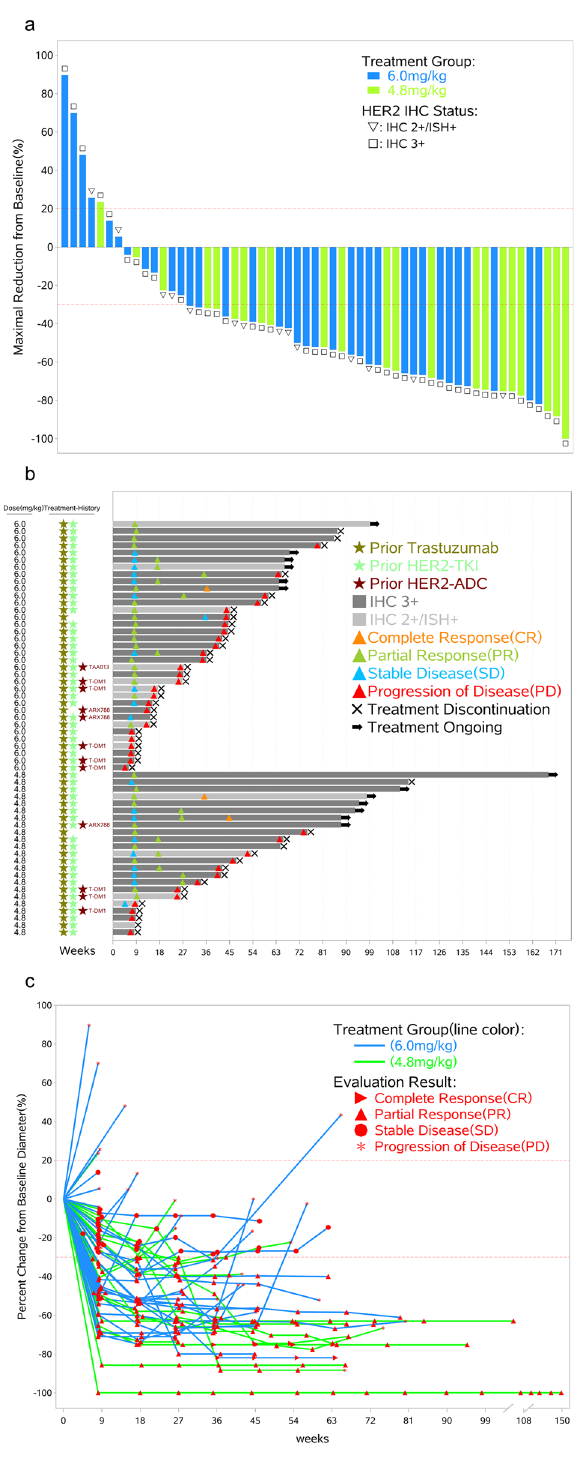
Fig. 2 Waterfall, swimmer, and spider plots by dose level in the 4.8 and 6.0 mg/kg cohorts of HER2-positive breast cancer patients ( n = 58). a Waterfall plot: maximal change in tumour target lesion size from baseline using RECIST v1.1 for patients with at least one posttreatment radiographic evaluation. The length of the bar represents the maximal decrease or minimal increase in the target lesion(s). b The swimmer plot shows the response and durations of response in the evaluated patients. c Change in individual tumour burden over time from baseline assessed using RECIST v1.1. Tumour response was assessed before treatment and once every 9